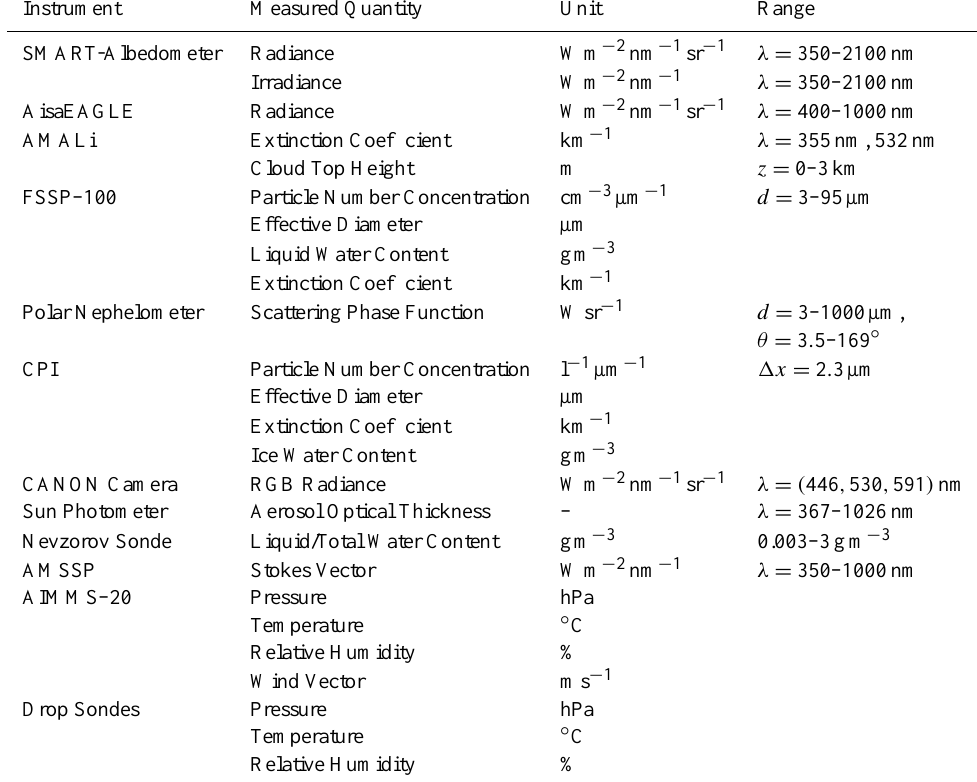
Table 1. Instrumentation of the Polar-5 aircraft during SoRPIC. Acronyms: AMALi (Airborne Mobile Aerosol Lidar), FSSP (Forward Scat- tering Spectrometer Probe), CPI (Cloud Particle Imager), AMSSP (Airborne Multi Spectral Sunphoto- and Polarimeter), AIMMS (Advanced Airborne MeasureMent